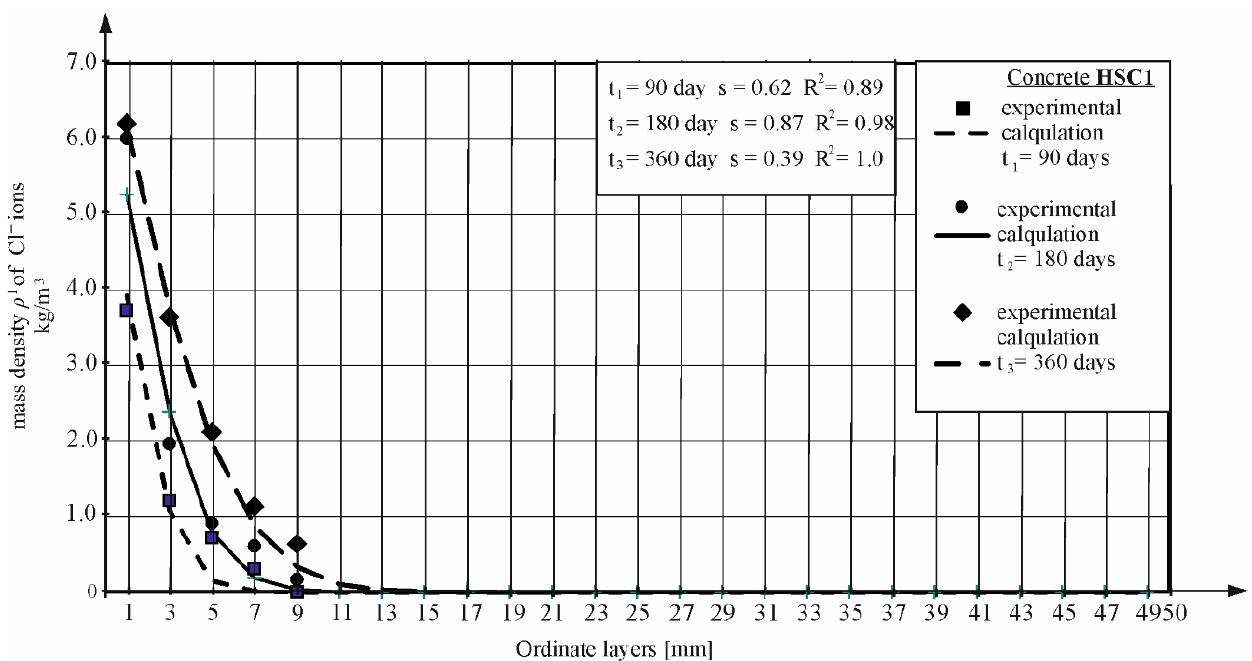
Figure 7. Chloride ion profile determined in diffusion tests in time t 1 and t 2 and calculated using the Equations (4) and (5) in concrete (TD1 and TD2): ( a ) SCC3; ( b ) SCC4.